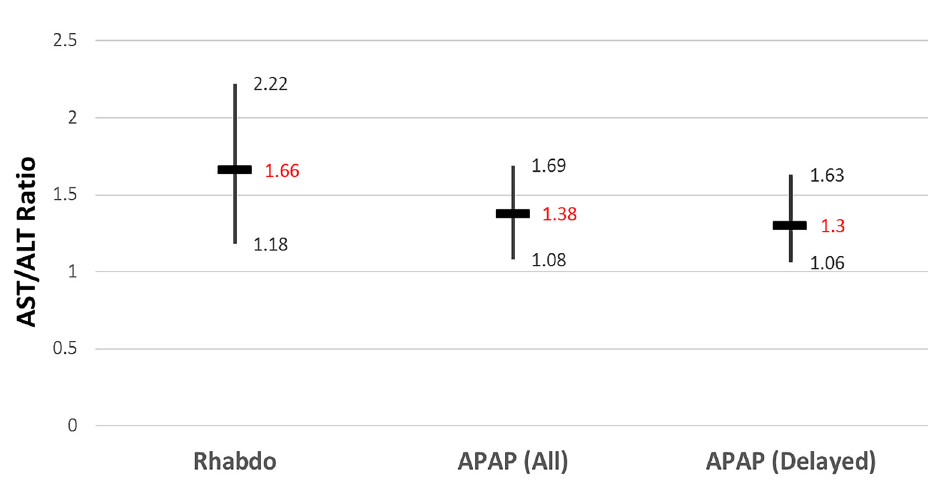
Figure 1. AST/ALT ratios of the three patient groups. Rhabdo , rhabdomyolysis group; APAP (all) , all patients with acetaminophen overdose; APAP (delayed) , patients with delayed acetaminophen toxicity. Vertical bars indicate interquartile range of values; horizontal bars indicate median values.